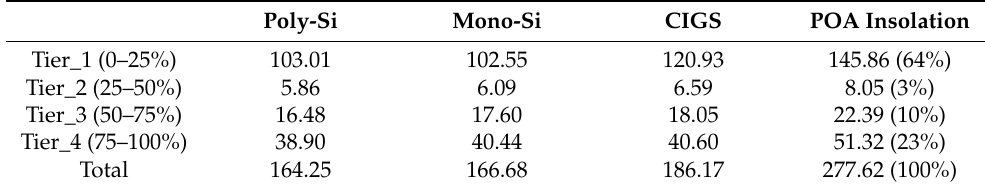
Table 4. Final yield (kWh/kW) for each technology in each tier for December 2019 and January 2020.